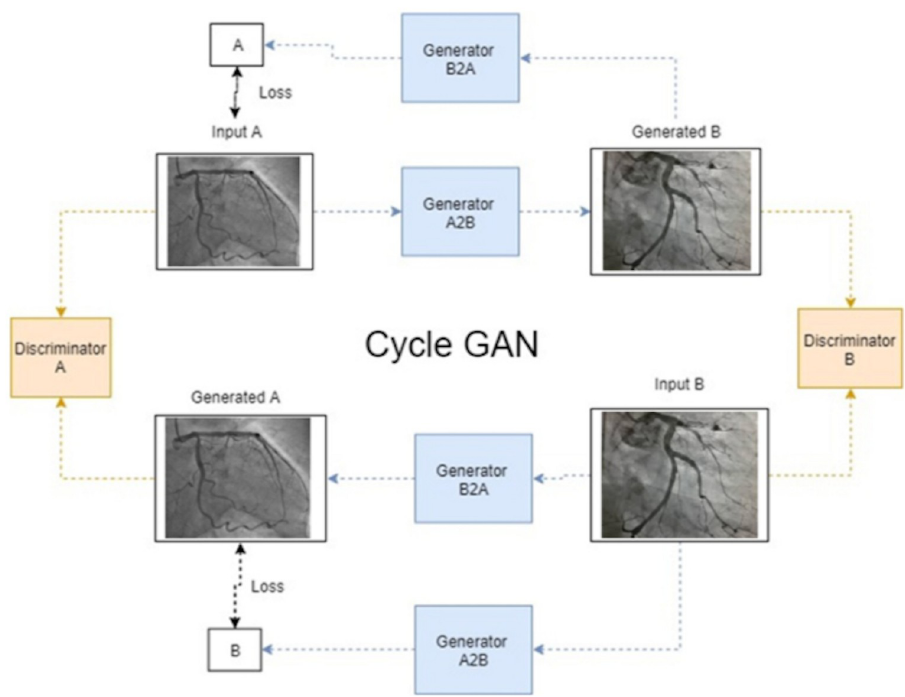
Fig 4. Cycle GAN approach for performing style transfer between healthy and pathological coronary angiography images slices.